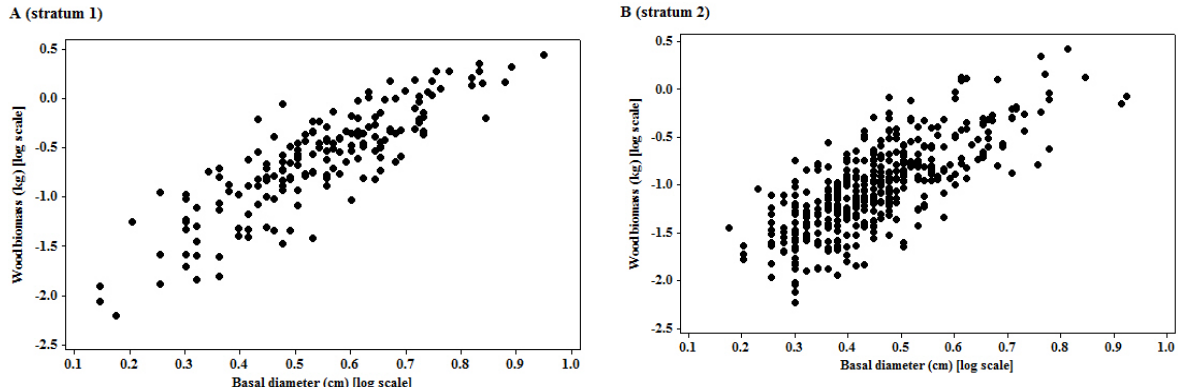
Figure 1. Relationship of woody biomass with basal diameter.